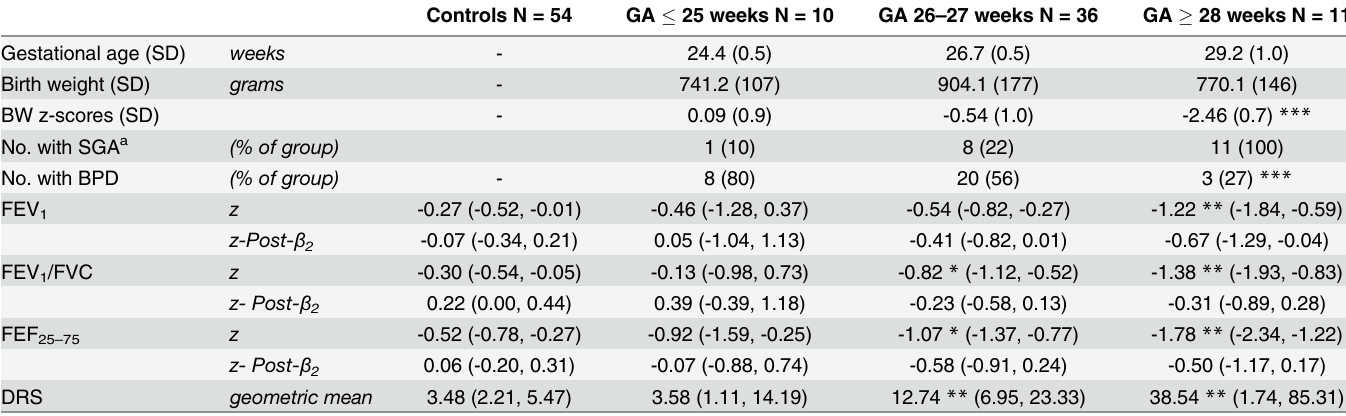
Table 4. Lung function variables reflecting airway flow before and after administration of salbutamol, and bronchial responsiveness to methacho- line, in 11 year old children born preterm (EP) in 1999 – 2000, split by gestational age (GA) at